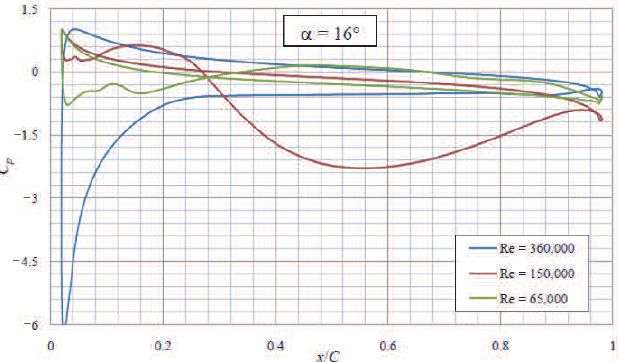
Figure 27. Pressure coefficient along airfoil as a function of distance from leading edge for α = 16 ◦